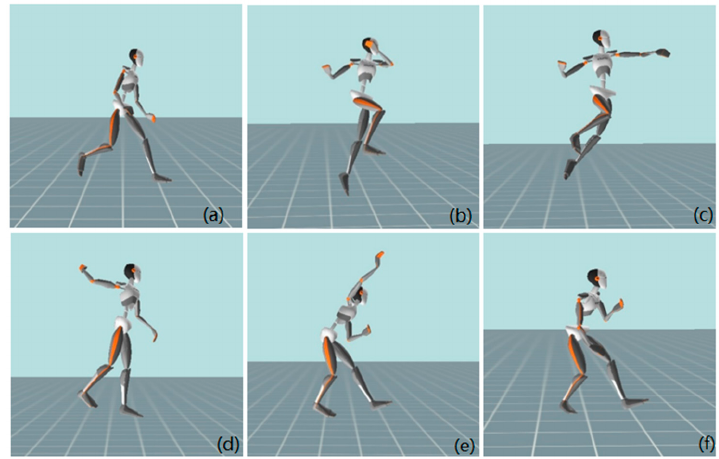
Figure 2. Kinogram of the final phase of the jump shot on the goal ( a ) final step; ( b ) take-off, ( c ) and ( d ) preparation for the shot; ( e ) shot, and ( f ) landing.